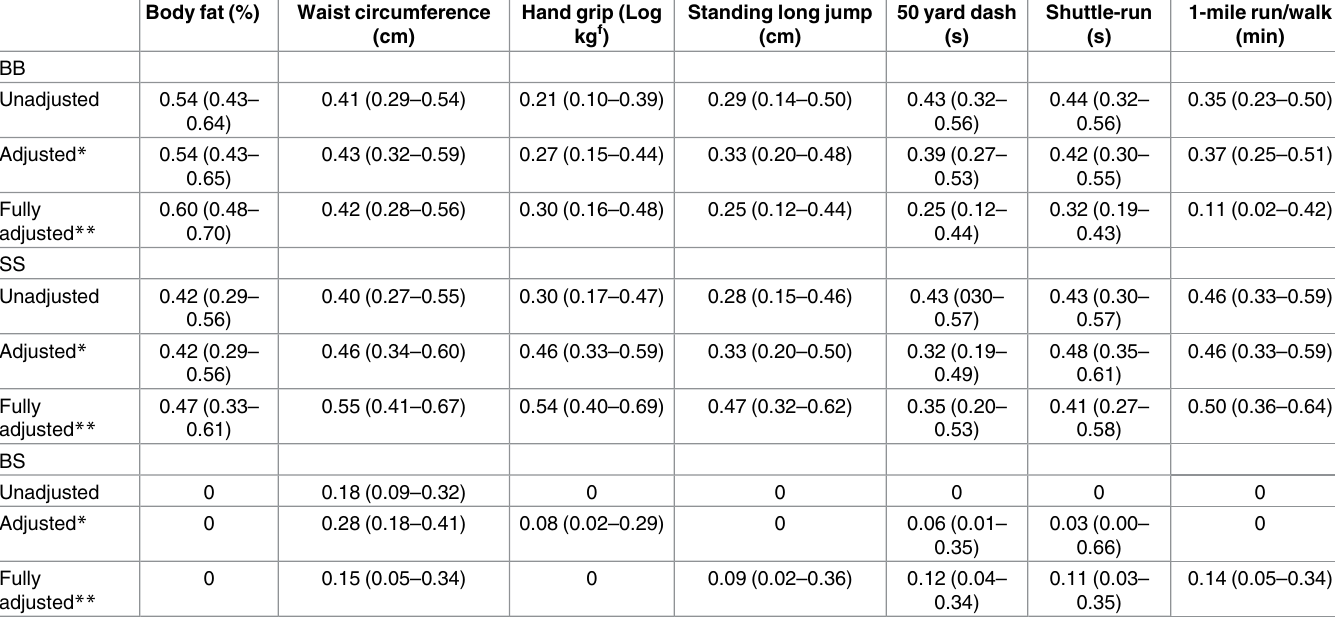
Table 3. Intraclass correlation coefficients ( ρ ) and (95% CI) for each physical fitness